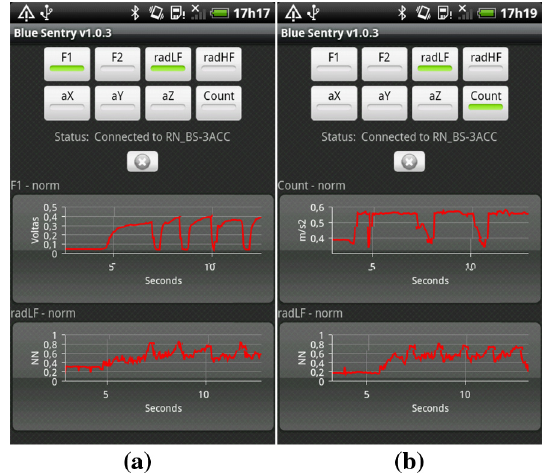
Figure 14. Graphical user interface of the application for force and radar response during physiotherapy training